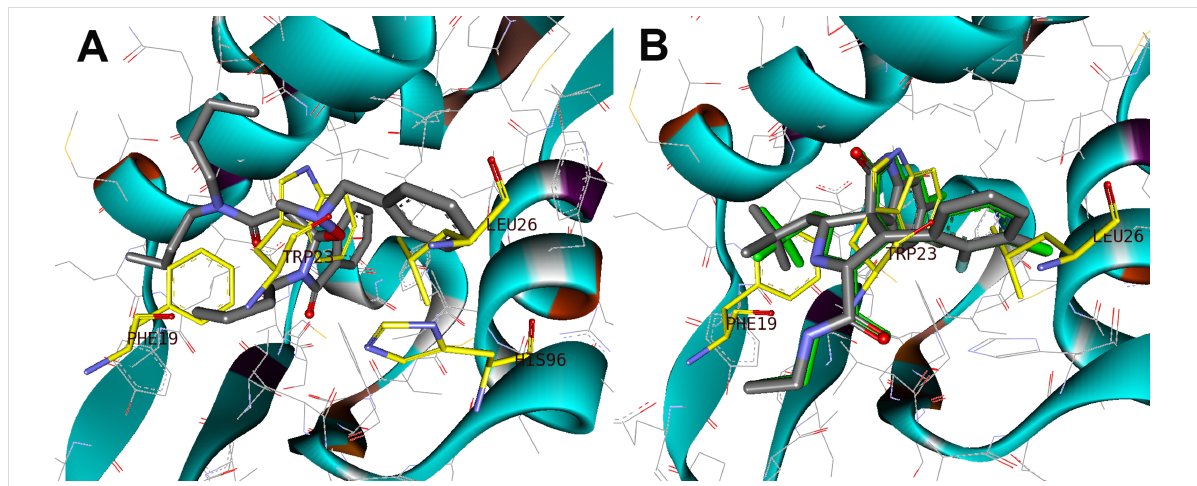
Figure 13: A) Compounds 6e (green) docked into MDM2 structure (PDB-ID: 3LBL); His96 and p53 residue (yellow sticks, PDB-ID 1YCR) are included for reference. B) Co-crystal structure of MI63-analogue in MDM2 and redocked MI63-analogue (green sticks) superimposed on the key amino acid side chain residue of the p53/MDM2 (yellow sticks, PDB-ID: